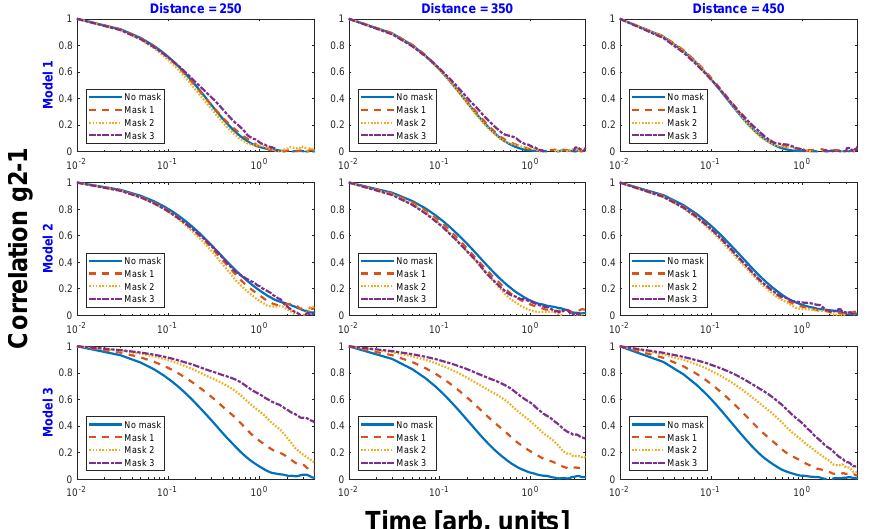
Figure 2. One-time correlation functions for the different models at distances 250, 350 & 450, for different masks. This representation stresses the effect of adding masks for each